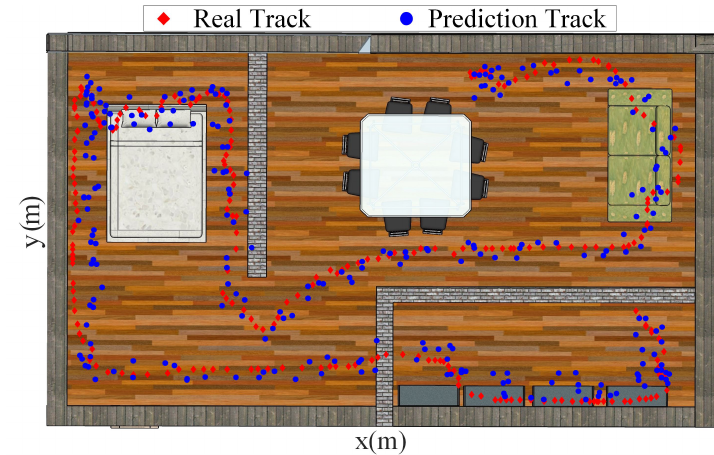
Figure 14. The trajectory prediction of the mobile device by the proposed algorithm. Table 5. Errors and time-consuming comparisons with other existing